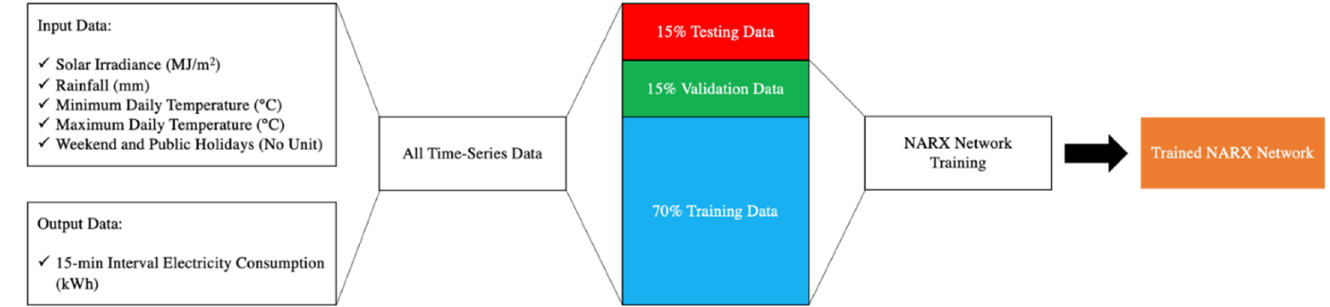
Figure 3. NARX Network training phase using training and validation data (85% of all data).